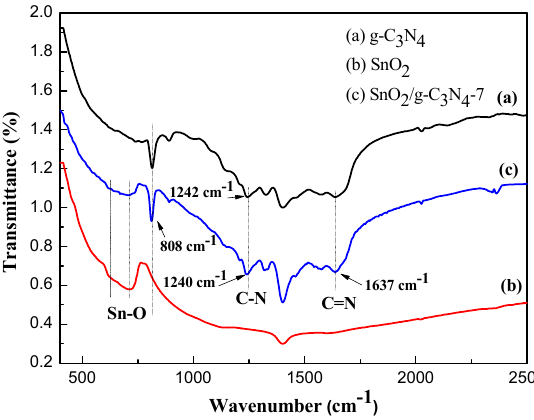
Figure 3. Fourier transform infrared spectrometer (FT-IR) spectra of g-C 3 N 4 ( a ); SnO 2 ( b ); and SnO 2 /g-C 3 N 4 -7 ( c ) nanocomposite.